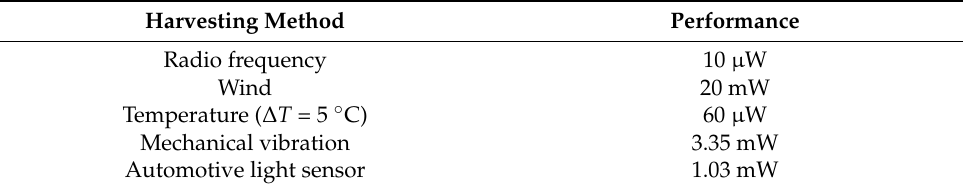
Table 1. Energy harvesting approach and their verified capabilities.